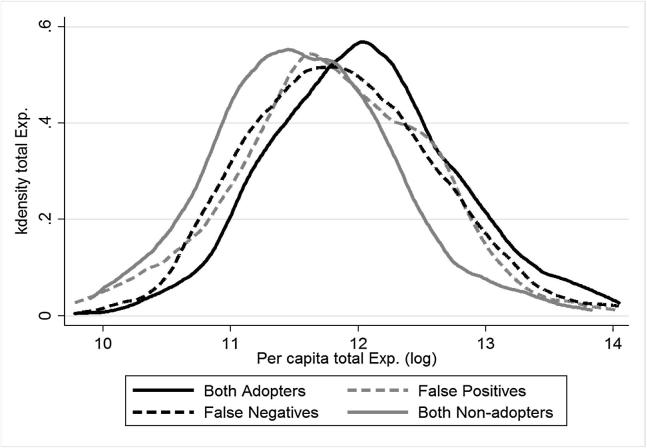
Total expenditure by misclassification status.